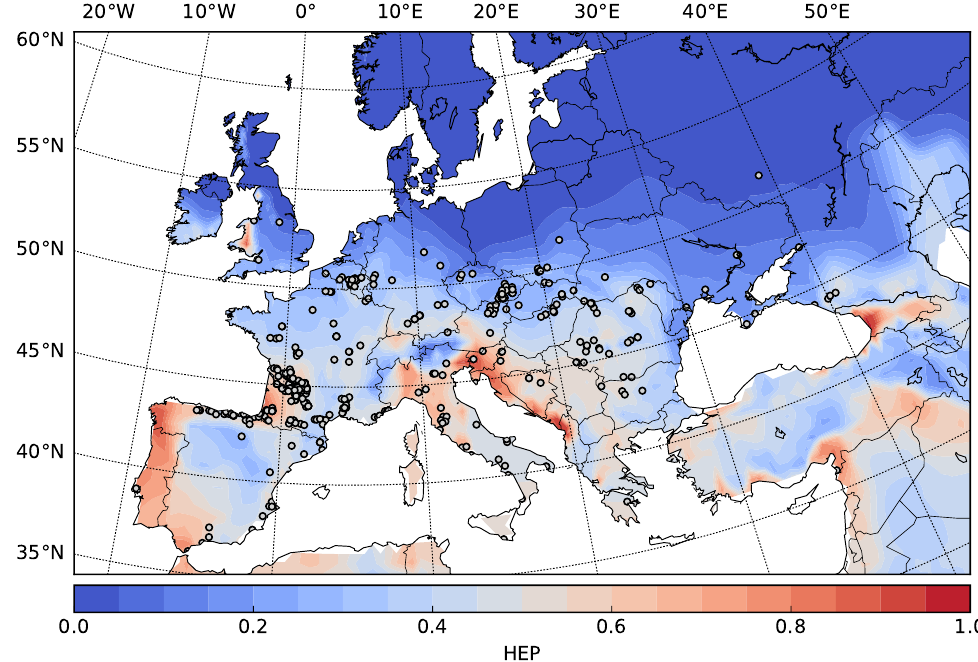
Figure 9. Estimation of the human existence potential (HEP) of the cold stadials during the Aurignacian technocomplex. Excavation sites are presented as white